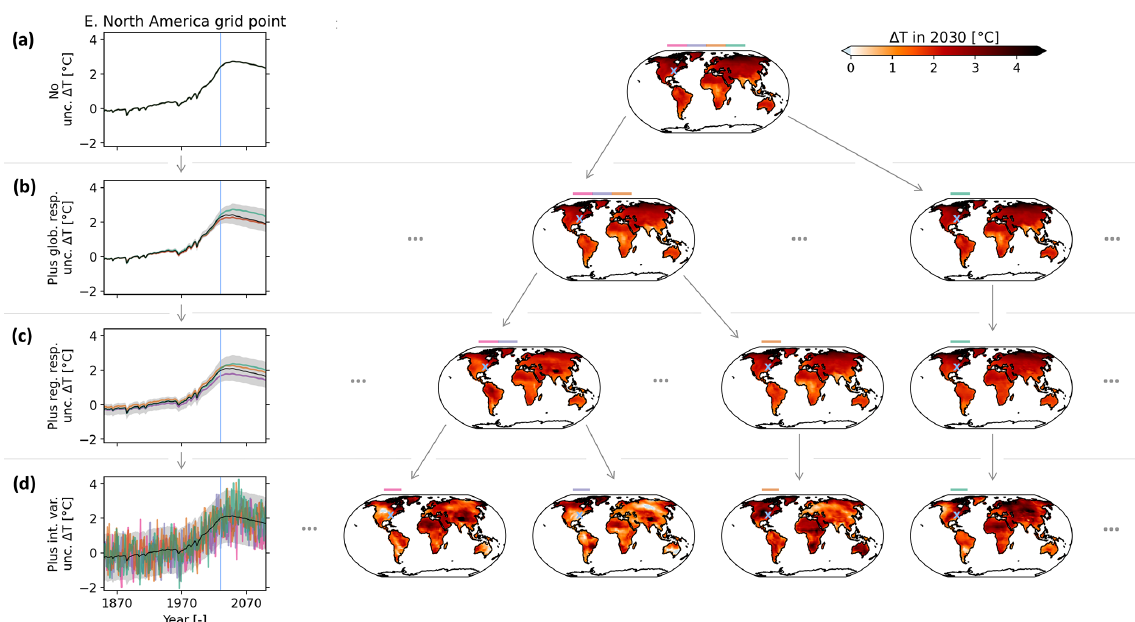
Figure 2. Visualization of the cumulative contribution of different uncertainty sources accounted for in the MAGICC–MESMER emulator chain with time series for a single grid point in eastern North America and with maps of example realizations for the year 2030 for the low-emission scenario SSP1-1.9. The example emulations shown in the maps are also depicted in the grid-point-level time series by using the colors displayed on top of the maps. Note that whenever several colors are depicted on top of a single map, the associated emulations all exhibit an identical temperature change trajectory. Hence, the individual example emulations fully overlap both in the map and in the time series plot. Light blue markers are employed to indicate the year 2030 in the time series plots and to show which location the time series belong to on the maps. From top to bottom, the rows exhibit an increasing reflection of uncertainties. Panel (a) accounts for no uncertainty since a single MAGICC forced global warming time series is combined with a single MESMER forced response pattern, meaning that all emulations are identical. Panel (b) accounts for the uncertainty in the global response by combining all of MAGICC’s forced global warming time series with a single MESMER forced response pattern. In the time series plot, the solid black line indicates the median of the temperature change distribution for that grid point, and the gray shading shows the 90% range (5th–95th percentile). Panel (c) adds uncertainty in the regional response by combining all of MAGICC’s forced global warming time series with all of MESMER’s forced response patterns. Panel (d) adds natural internal variability provided by MESMER on top of the forced response